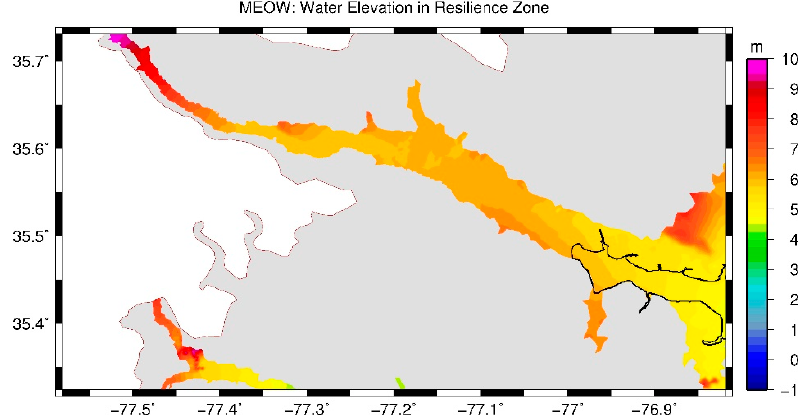
Figure 14. Maximum envelope of total water in the resilience area for all CAT345 storms; color bars indicate water level (m) relative to MSL, black line denotes coastline and gray region denotes the dry regions within the ADCIRC model.